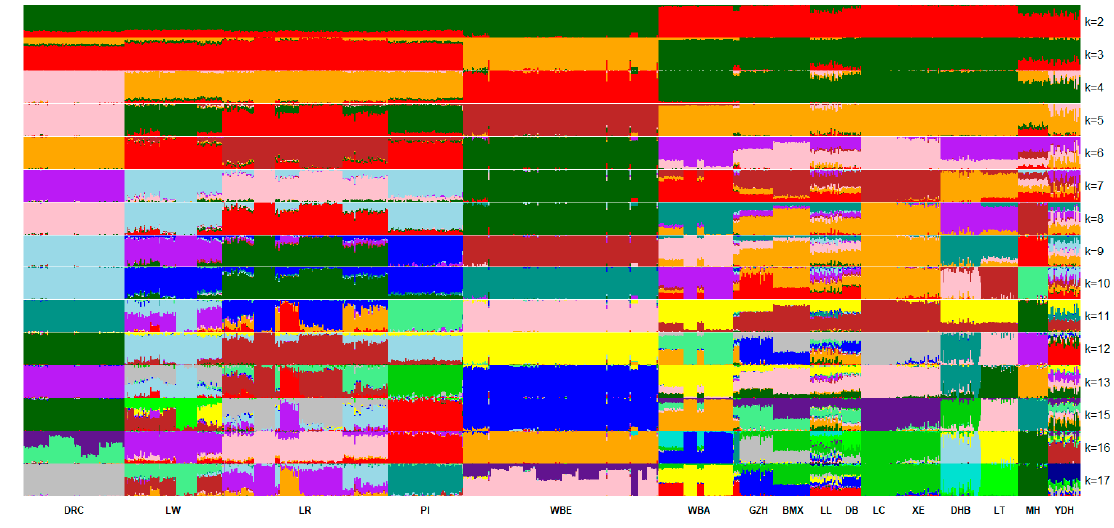
Figure 4. Structure results 1 . 1 DR = Duroc, LW = Large White, LR = Landrace, PI = Pietrain, WBE = European wild boars, WBA = Asian wild boars, BMX = Bamaxiang, DB = Debao, DHB = Dahuabai, GZH = Guizhonghua, LC = Luchuan, LL = Longlin, LT = Lantang, MH = Meihua, XE = Guangdongxiaohua, YDH = Yuedonghei.